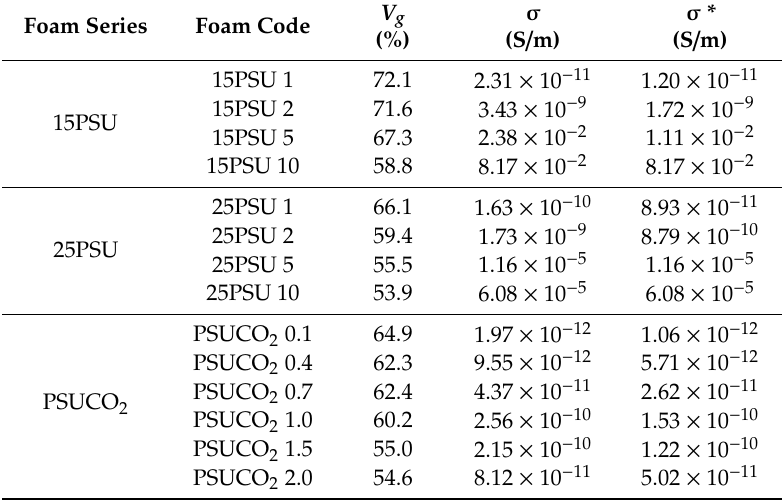
Table 2. Electrical conductivity and corresponding corrected values of the PSU – GnP microcellular nanocomposites. Foam